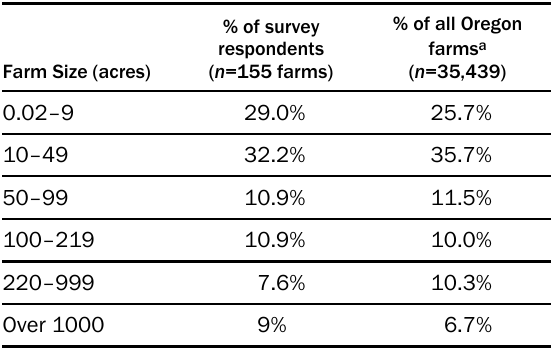
Table 2. Comparison of Surveyed Farms vs. All Oregon Farms’ Size by